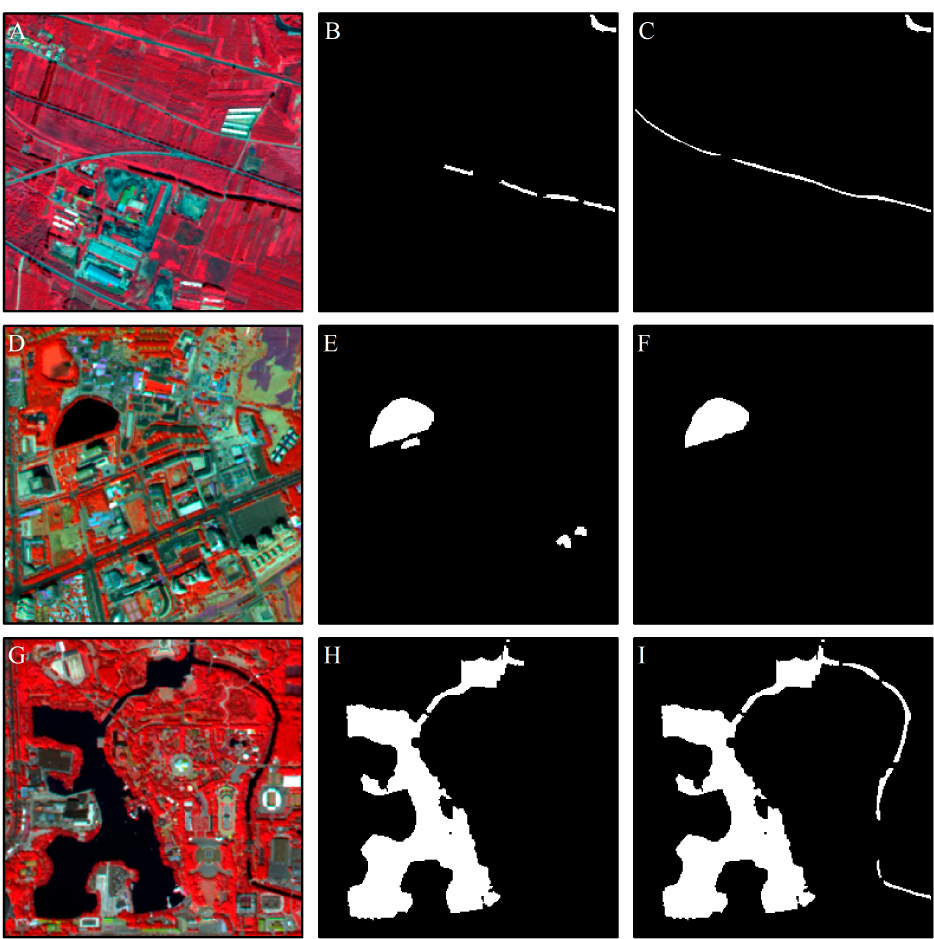
Figure 11. Column 1: False color images; Column 2: Detected water bodies before post-classification improvement; Column 3: Detected water bodies after post-classification improvement.